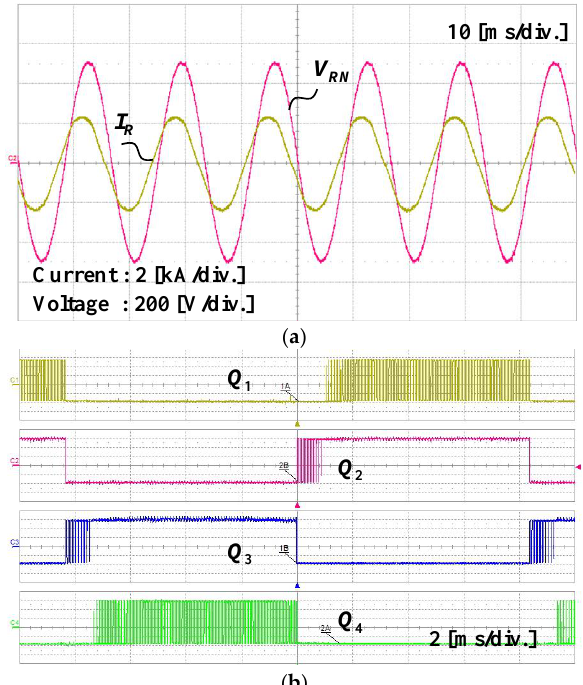
Figure 16. Experimental results in the case where the power factor is controlled at 0.9 (lag) using the proposed switching scheme: ( a ) waveforms of the output voltage and current; ( b ) waveforms of the gate signal.